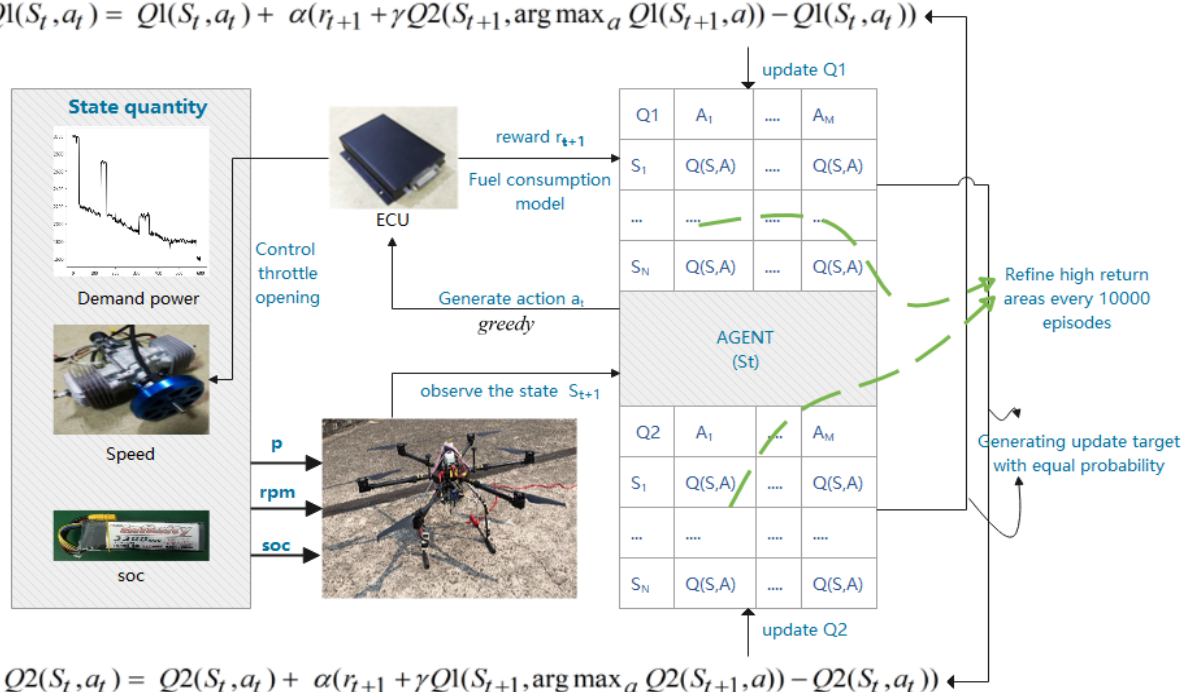
Figure 10. Application framework of improved double Q algorithm.